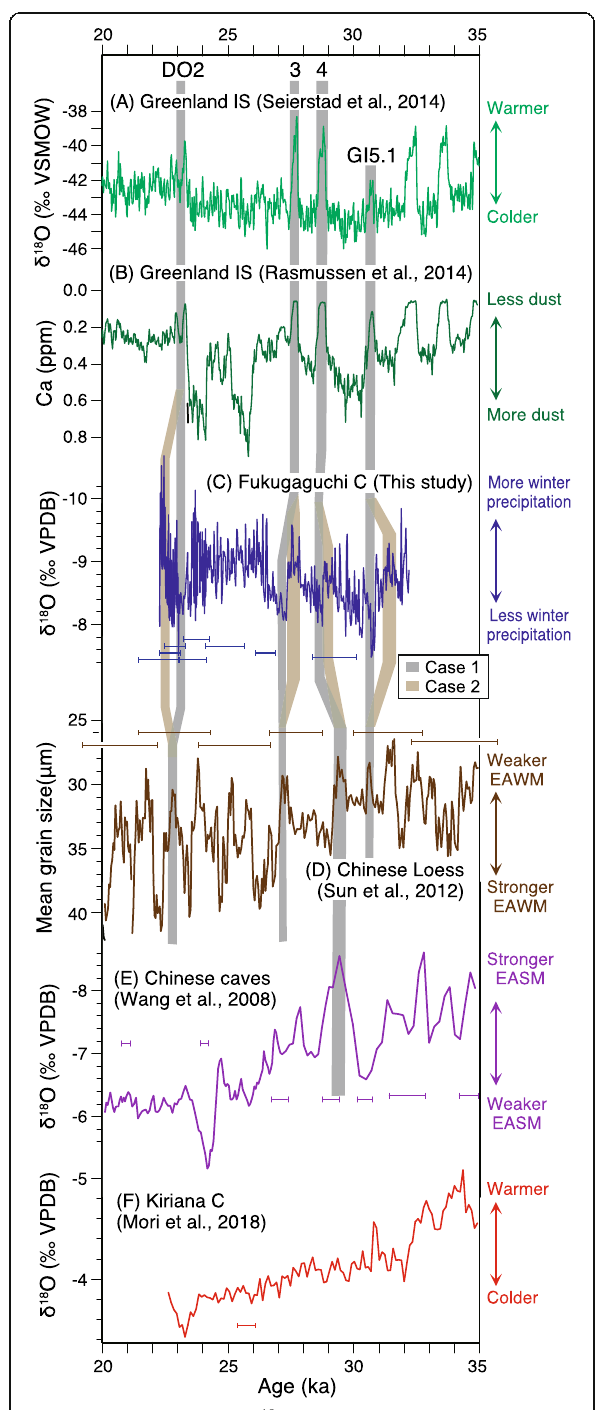
Fig. 6 Comparison of FG02 δ 18 O data and climate interpretation with other paleoclimatic studies in the period 20 – 25 ka. a Greenland ice core δ 18 O (Seierstad et al. 2014) and b Ca 2+ (Rasmussen et al. 2014). c FG02 δ 18 O data (this study). Climate interpretation is according to case 1. d Grain size variation of quartz in loess sediments from the Chinese Loess Plateau (Sun et al. 2012). e δ 18 O variability in Hulu Cave (south China; Wang et al. 2001). f δ 18 O variability in Kiriana Cave (Mie Prefecture, Japan; Mori et al.